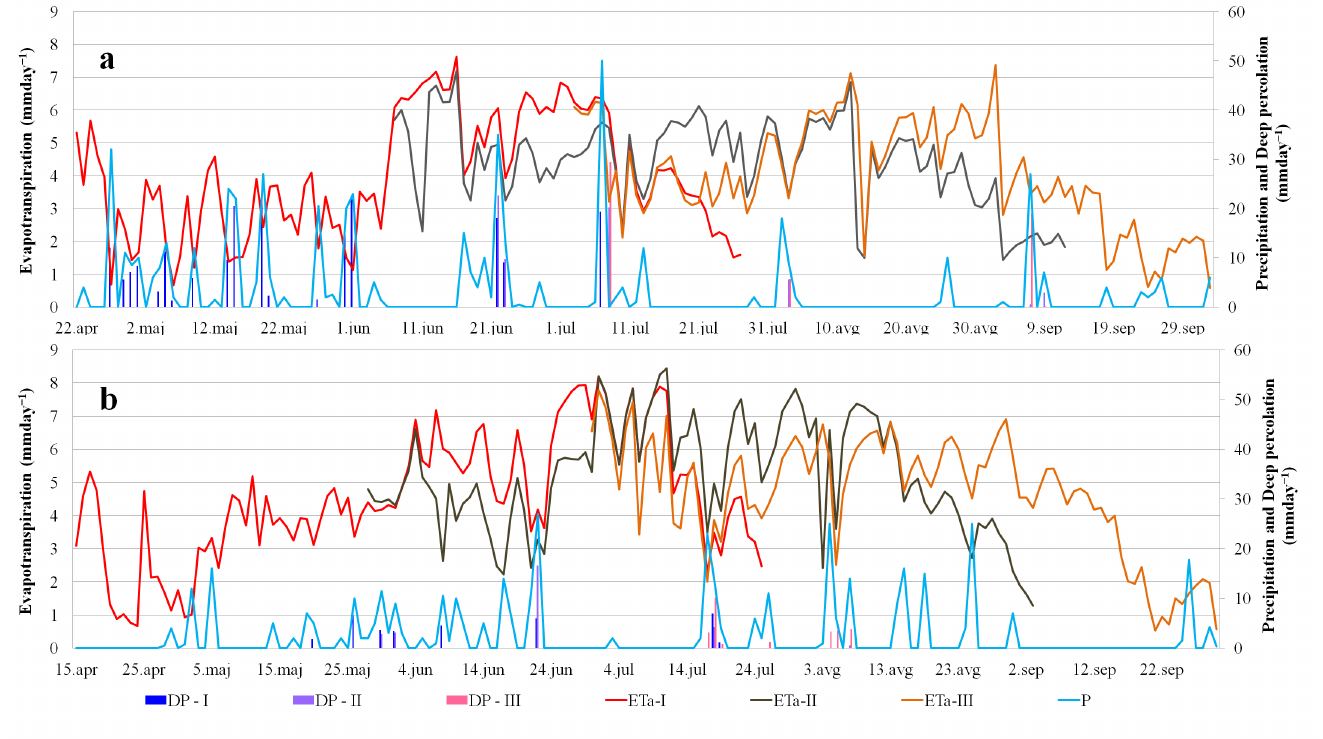
Figure 7. Actual evapotranspiration ( ETa ), precipitation (P) and deep percolation (DP) among sowing periods of common bean for the 2019 ( a ) and 2020 ( b